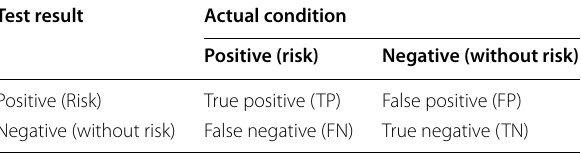
Table 2 Confusion matrix for credit